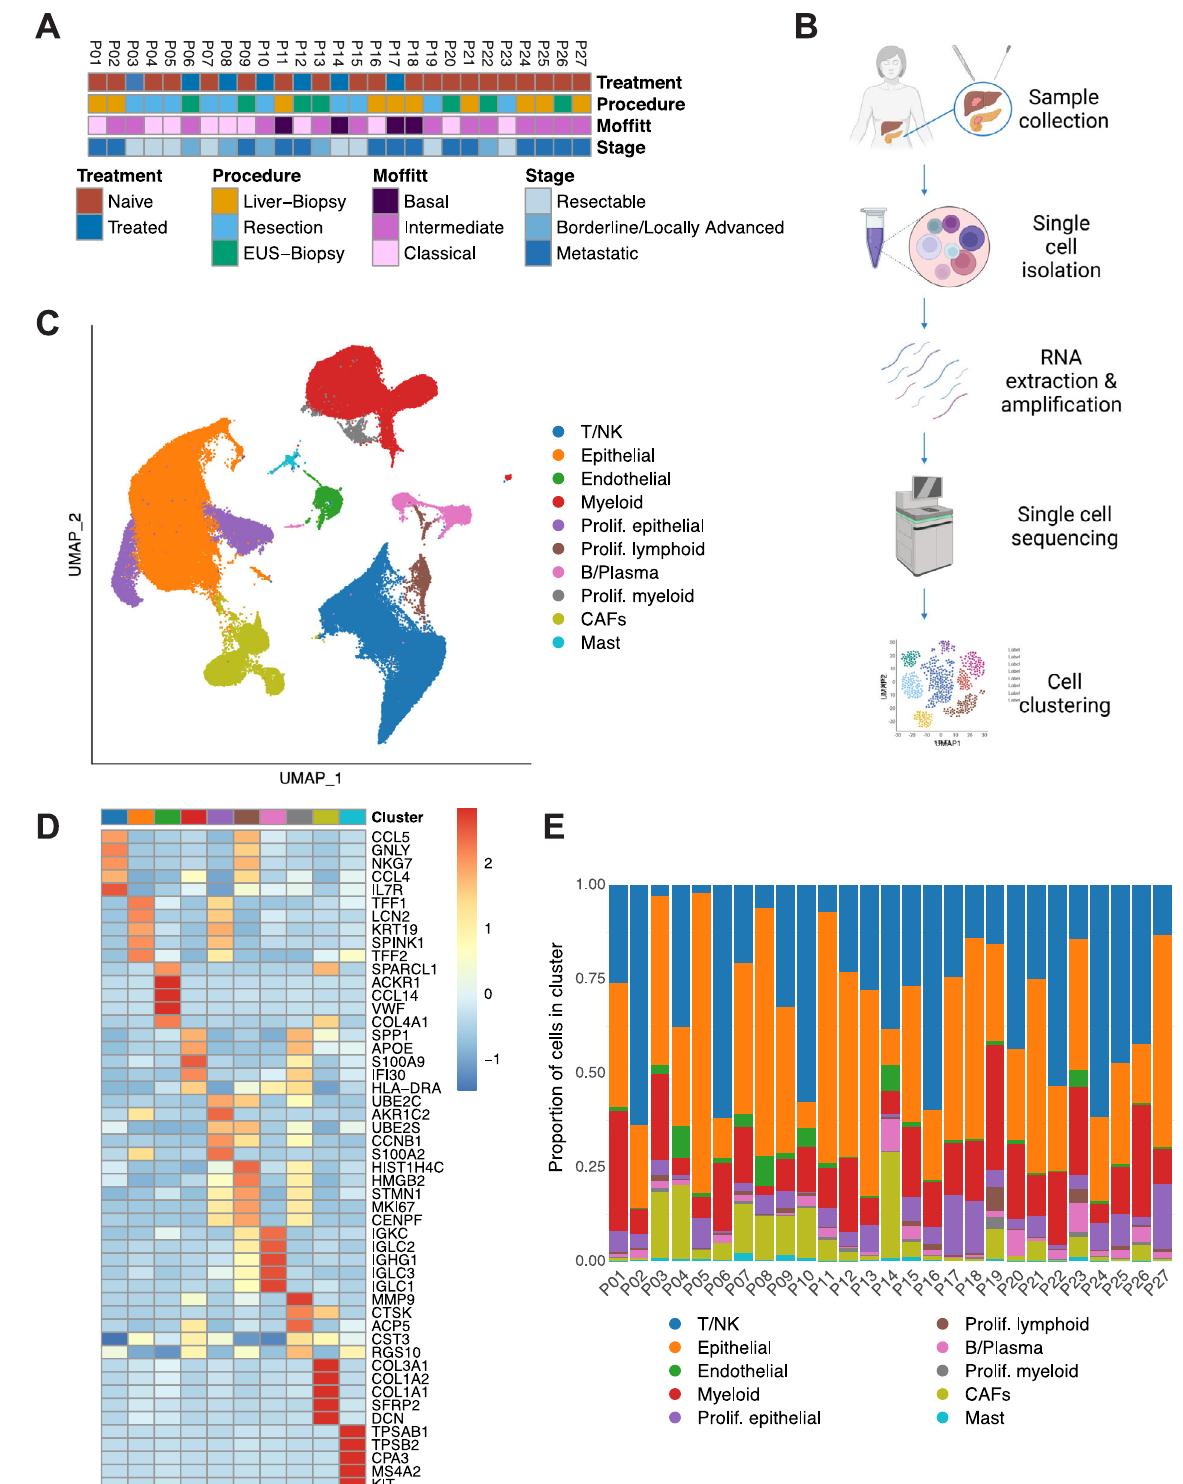
Fig. 1 | Single-cell analysis reveals the transcriptomic landscape in PDAC. A Clinicopathologic characteristics for each patient sample including treatment status, stage, Mof fi tt subtype, and procedure. EUS endoscopic ultrasound. B Work fl ow depicting sample acquisition, processing, and analysis. Designed with BioRender © . C UMAP, embedding of the expression pro fi le of 139,446 cells that passed quality control from n =27 patient samples. Distinct clusters are annotated